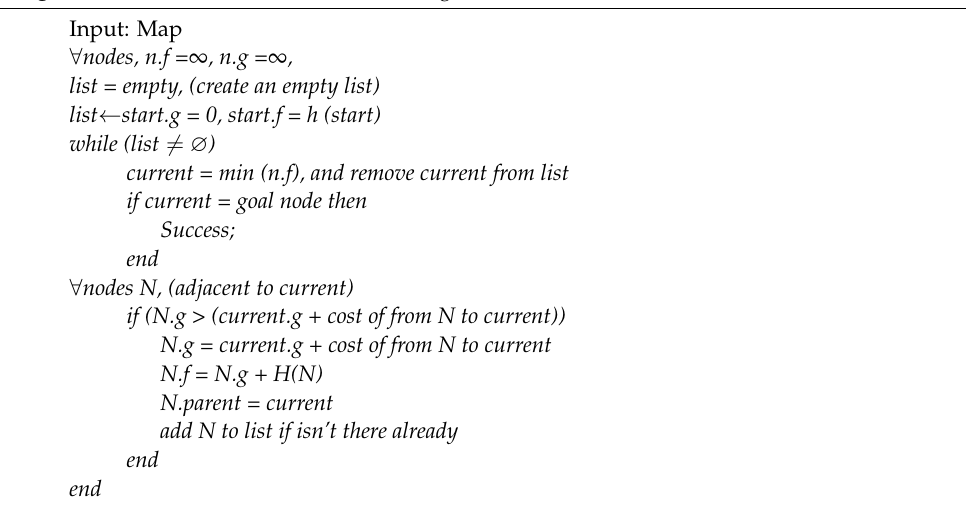
Algorithm 1 Pseudo code of the A-STAR